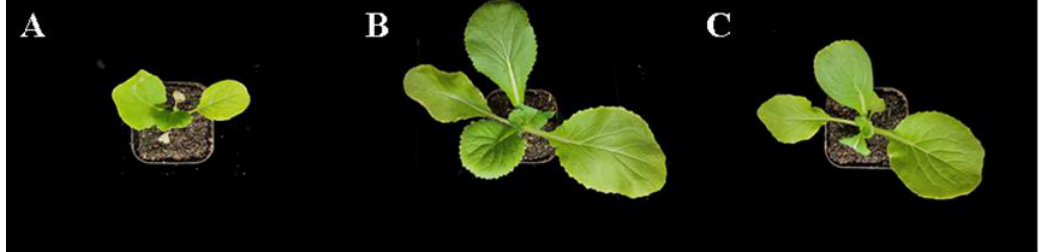
Figure 1. The phenotype of Chinese cabbage treated with water ( A ), Glu ( B ), or γ -PGA ( C ), followed by heat treatment. Table 1. Effects of Glu and γ -PGA on the vegetative growth of Chinese cabbage under heat stress. Fresh Weight Treatment (g · Plant − 1